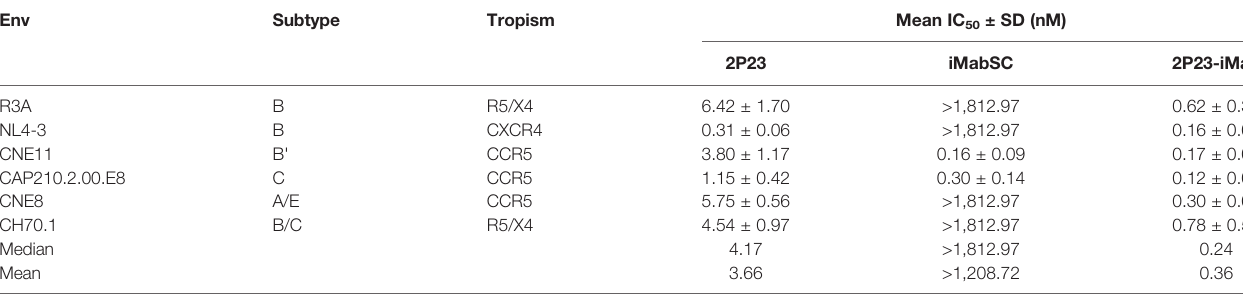
TABLE 3 | Inhibitory activities of 2P23-iMab and its template inhibitors against HIV-1 Env-mediated cell – cell fusion. Env